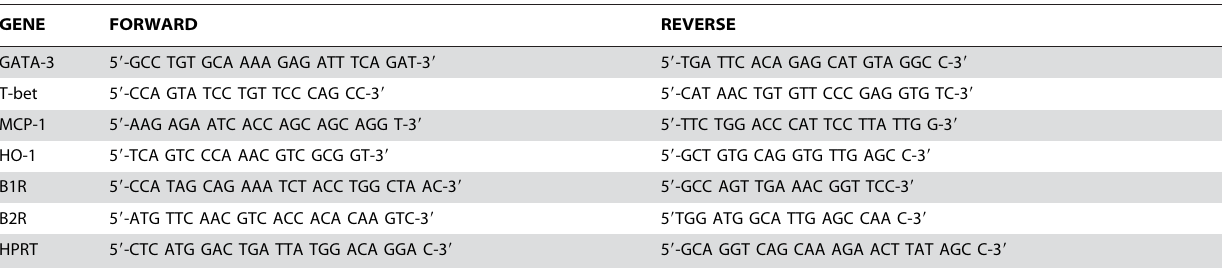
Table 1. Oligonucleotides sequence.